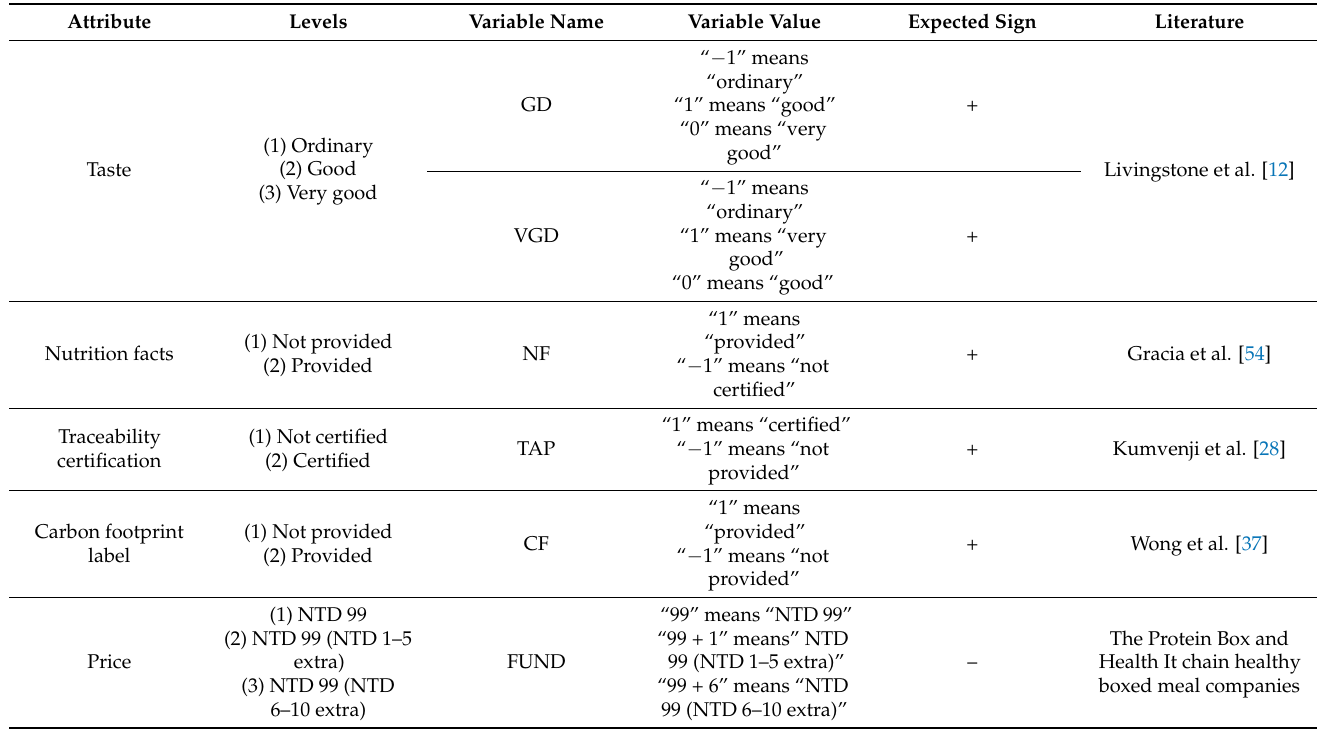
Table 1. Table 1. Attributes and attribute levels of healthy boxed